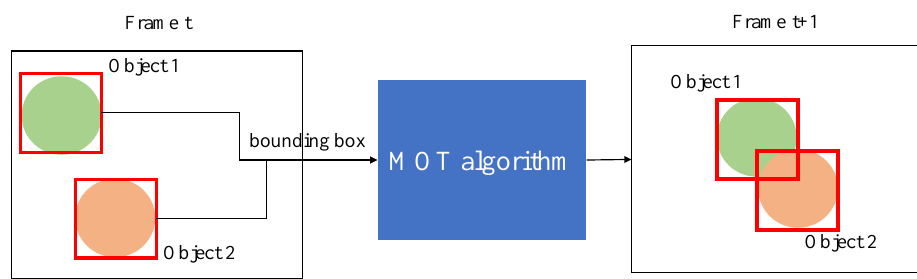
Figure 5. Description of a basic MOT process that includes (1) the detection of an object in frame t, (2) the exact position of the object is extracted and fed into an MOT algorithm, and (3) the object is tracked, and the object location at frame t+1 is